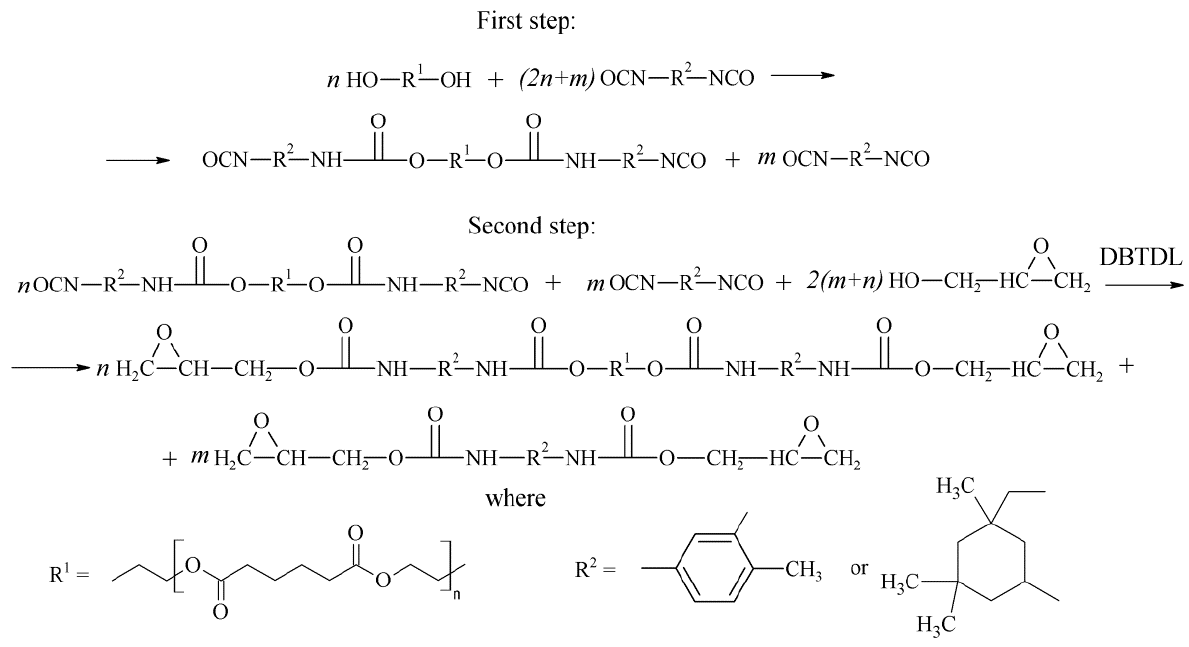
Figure 2. Synthetic route for epoxyurethane oligomers. The pre-synthesized polyesters were dried at 90 ◦ C for 7 h. Oligodiisocyanates were obtained via interaction of oligodiols and diisocyanate (NCO/OH = 2.05) at constant temperature of the reaction mixture of 70 ◦ C at stirring for 8 h. The content of NCO groups in the prepolymers was determined by titration with n-butylamine (standard method ASTM D